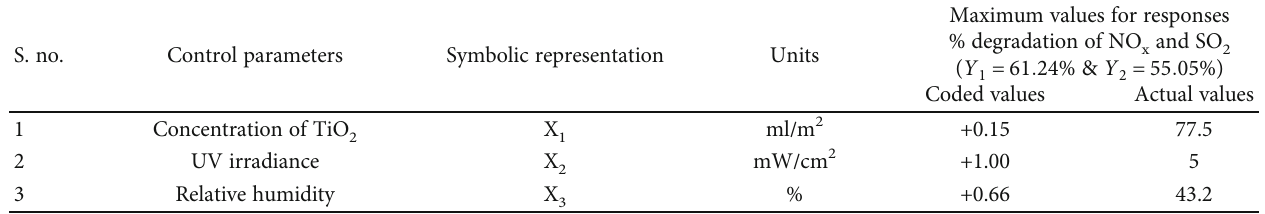
-based UV photocatalytic degradation of the pollutants. 2